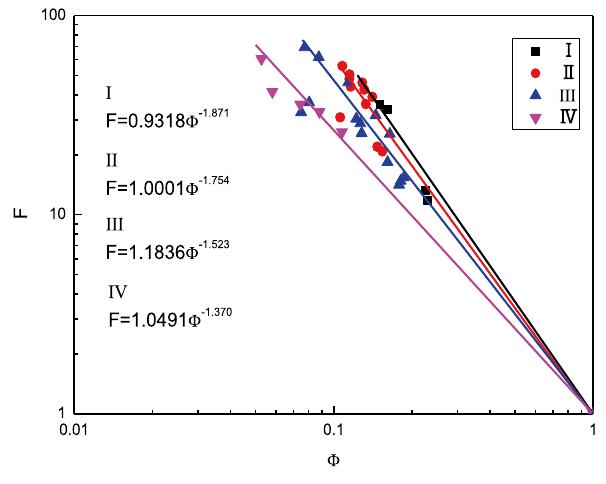
Fig. 10 F – Φ relationship diagram of rocks with different pore struc- tures